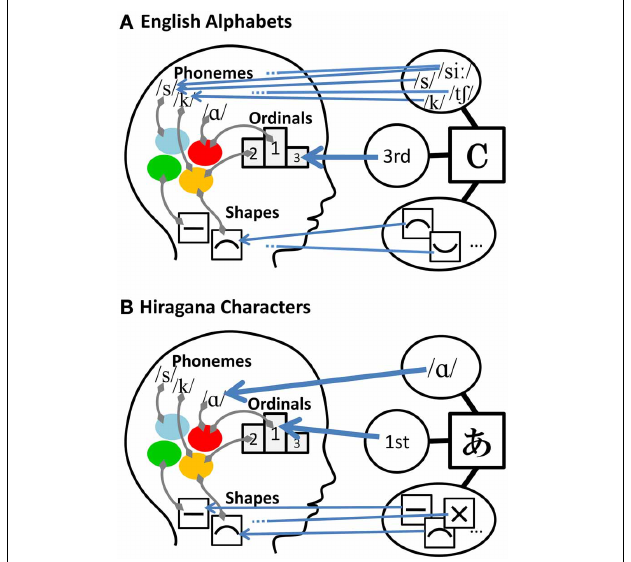
FIGURE 1 | Schematic illustrations of the comprehensive explanatory model of synesthetic grapheme-color association proposed in this study. In the case of English alphabets (A) and Hiragana characters (B)